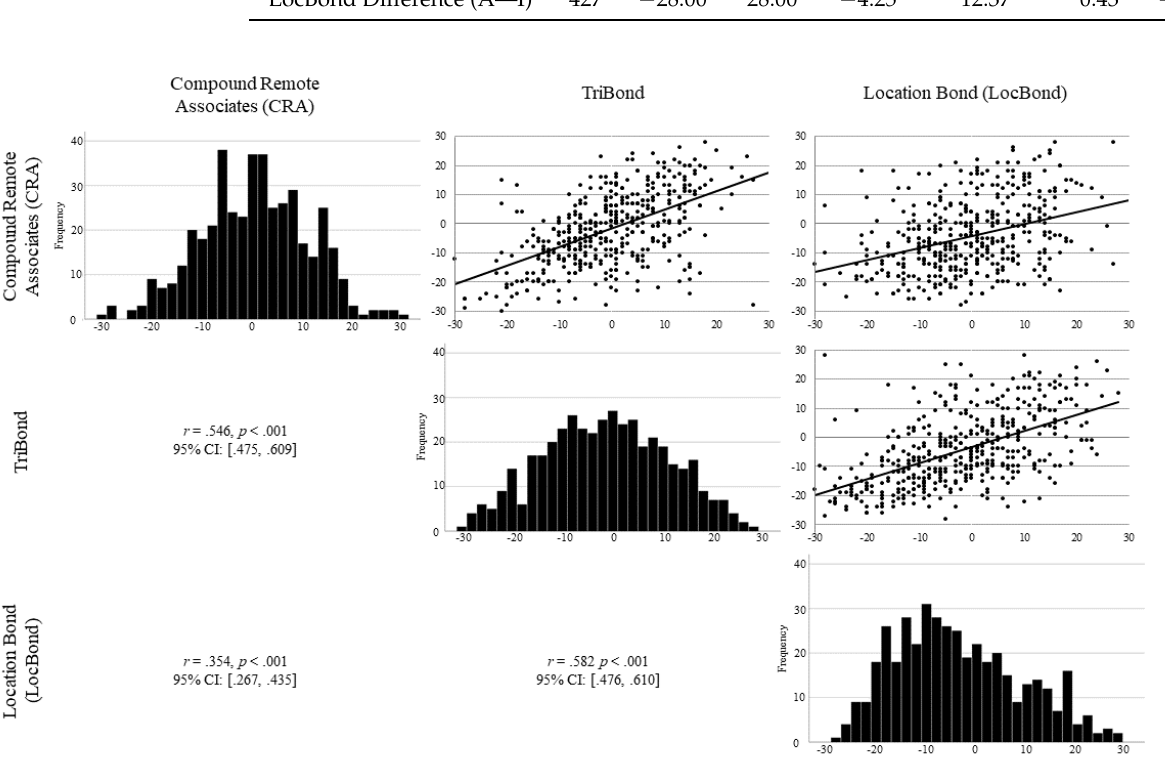
Figure 3. Scattermatrix with frequency distributions on the diagonal. Plotted are the difference scores for strategy usage (analytical-insight) counts (i.e., number of times a participant reported using each strategy) for the three multiply-constrained problem solving tasks (compound remote associates: CRA, TriBond, and Location Bond: LocBond).